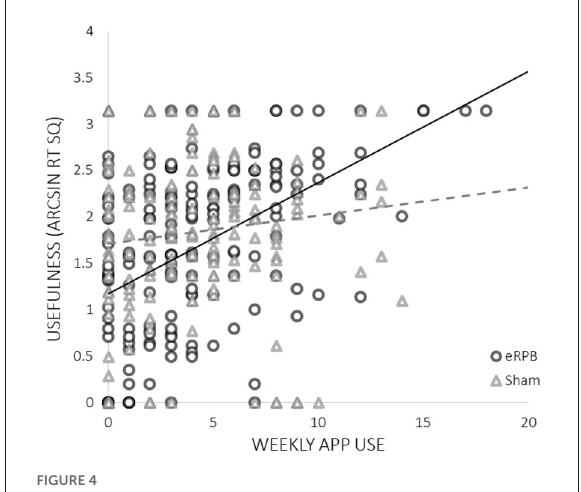
FIGURE4 Relationship between app use and ratings of usefulness by